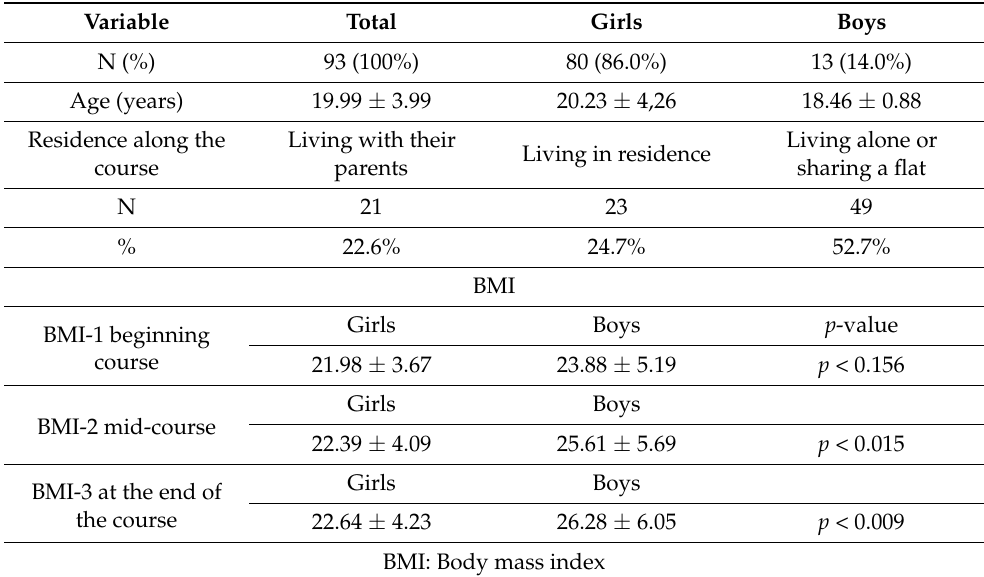
Table 1. Characteristics of student population in the study sample.